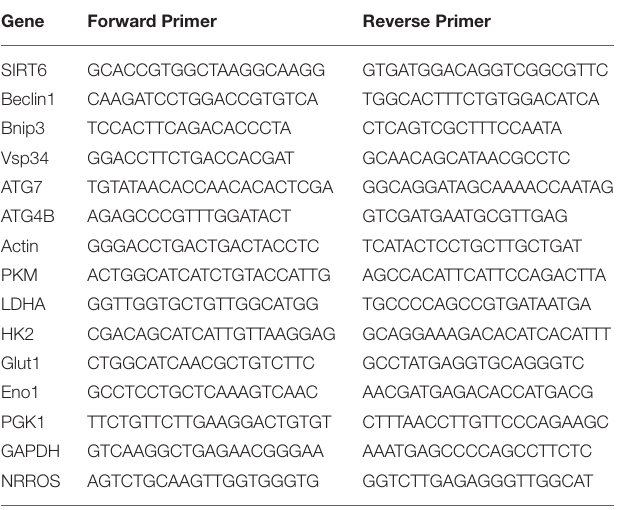
TABLE 1 | The Primers of RT-qPCR. Gene Forward Primer Reverse